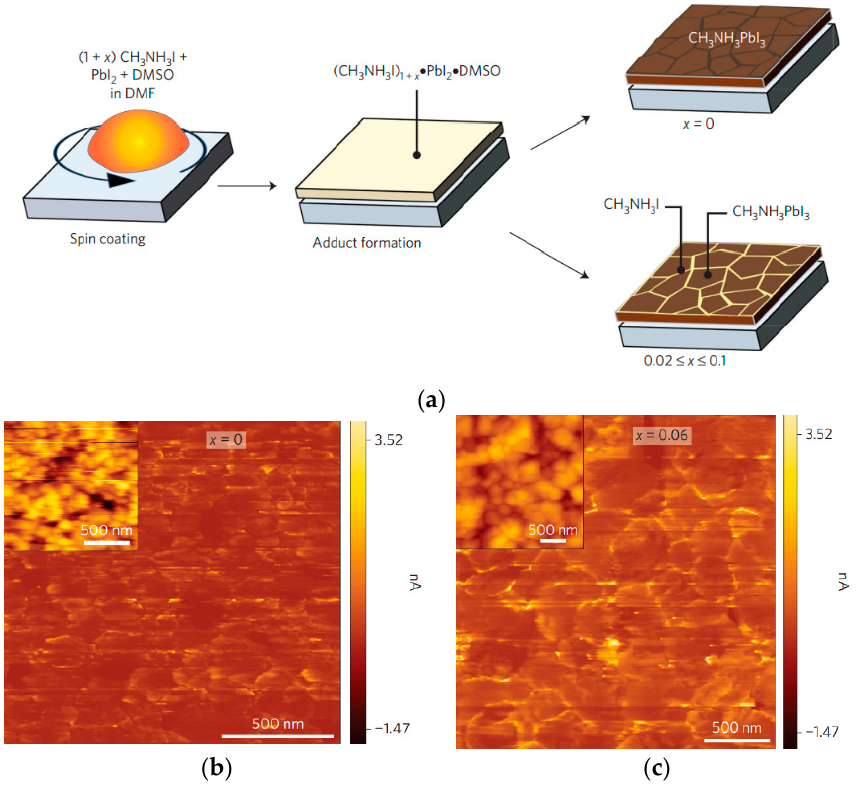
Figure 4. ( a ) Schematic illustration of the one-step coating process with and without MAI; c-AFM images of MAPbI 3 films with excess MAI for ( b ) x = 0; ( c ) x = 0.06 [43].